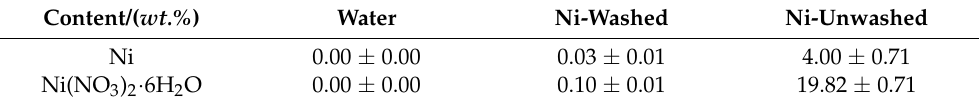
Table 1. The content of nickel nitrate in pretreated organsolv lignin (OL). Content/( wt.% ) Water